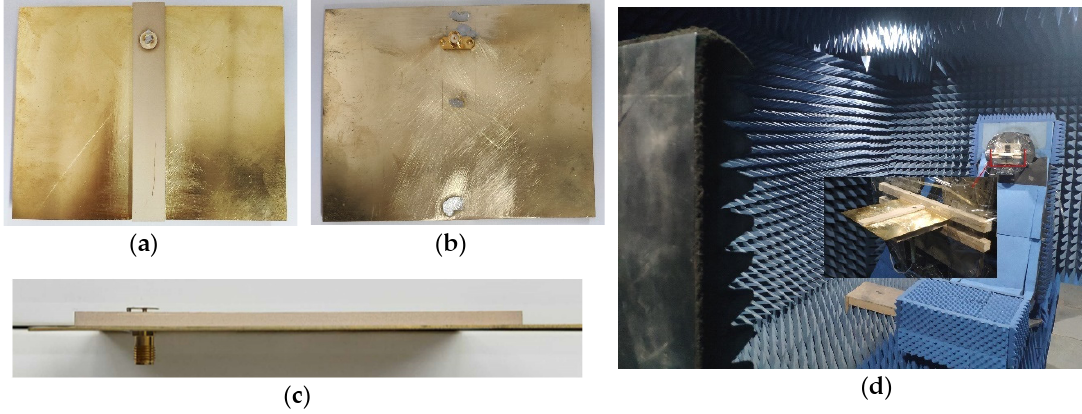
Figure 9. Photograph of the proposed surface wave antenna prototype and test environment: ( a ) top view; ( b ) bottom view; ( c ) side view; ( d ) anechoic chamber.